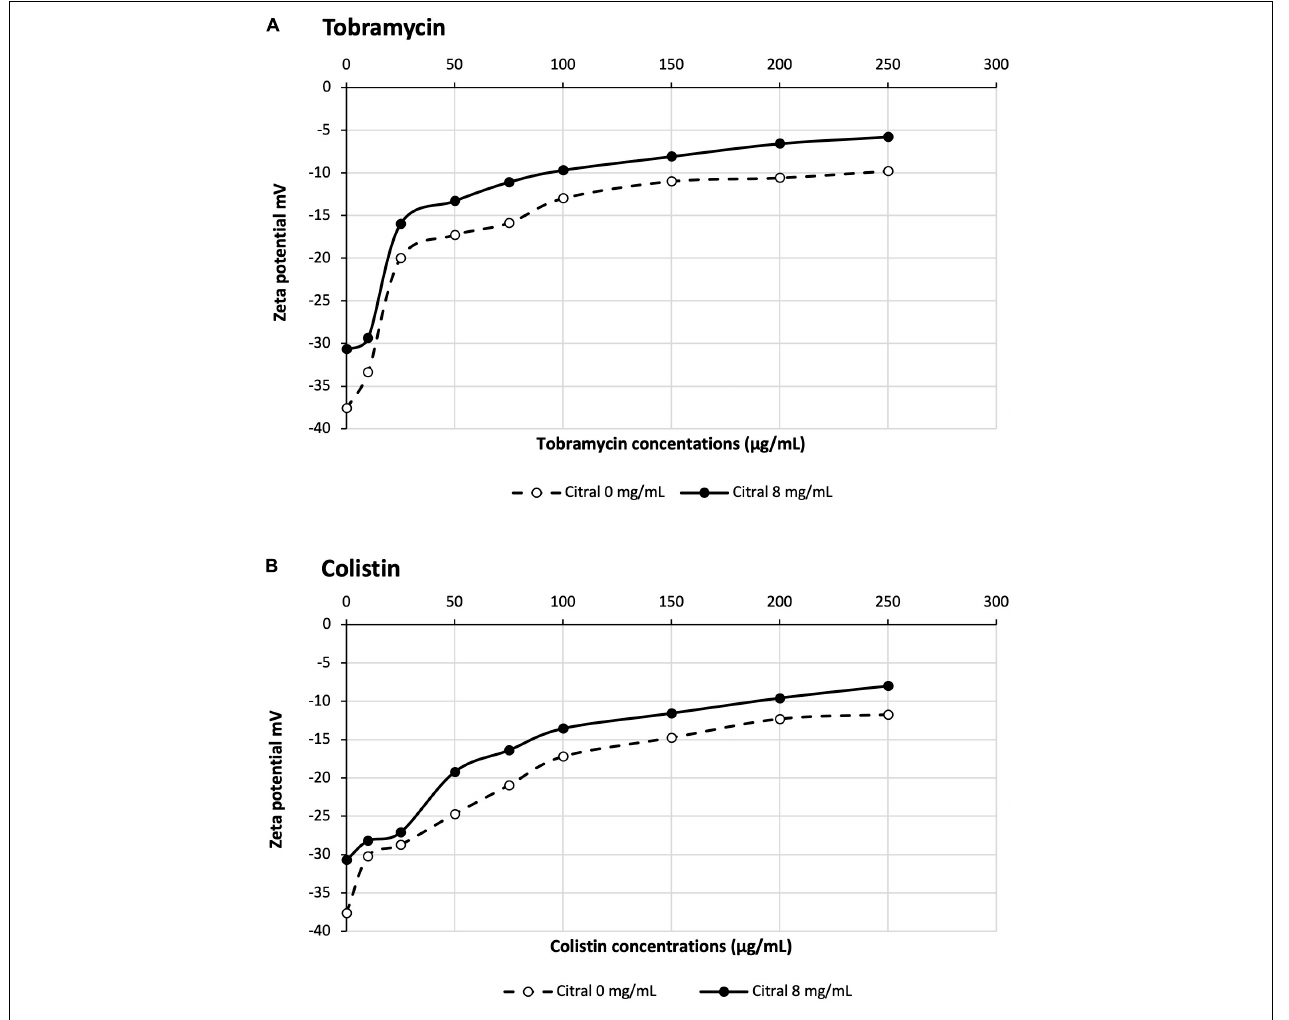
FIGURE 5 | Impact of citral on Zeta potential of PA14 cells treated with tobramycin (A) or colistin (B)